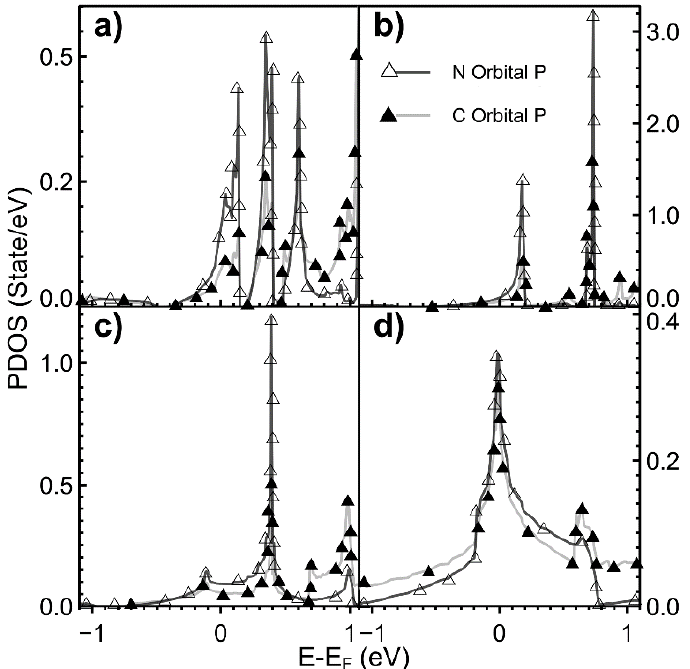
Figure 6. We show the PDOS for different values of vacancy densities when the dopant is nitrogen. ( a ) 2.00%; ( b ) 3.12%; ( c ) 5.55%; ( d ) 12.5%. For carbon: orbital s :  ; and for orbital p : ▲ . For nitrogen: ( a ) 2.00%; ( b ) 3.12%; ( c ) 5.55%; ( d ) 12.5%. For carbon; orbital p : (cid:78) . For nitrogen: (cid:52) . The energy range orbital s :  ; and orbital p :  . The energy range is from −1 .0 eV to +1.0 eV. The orbitals s for carbon appear in the